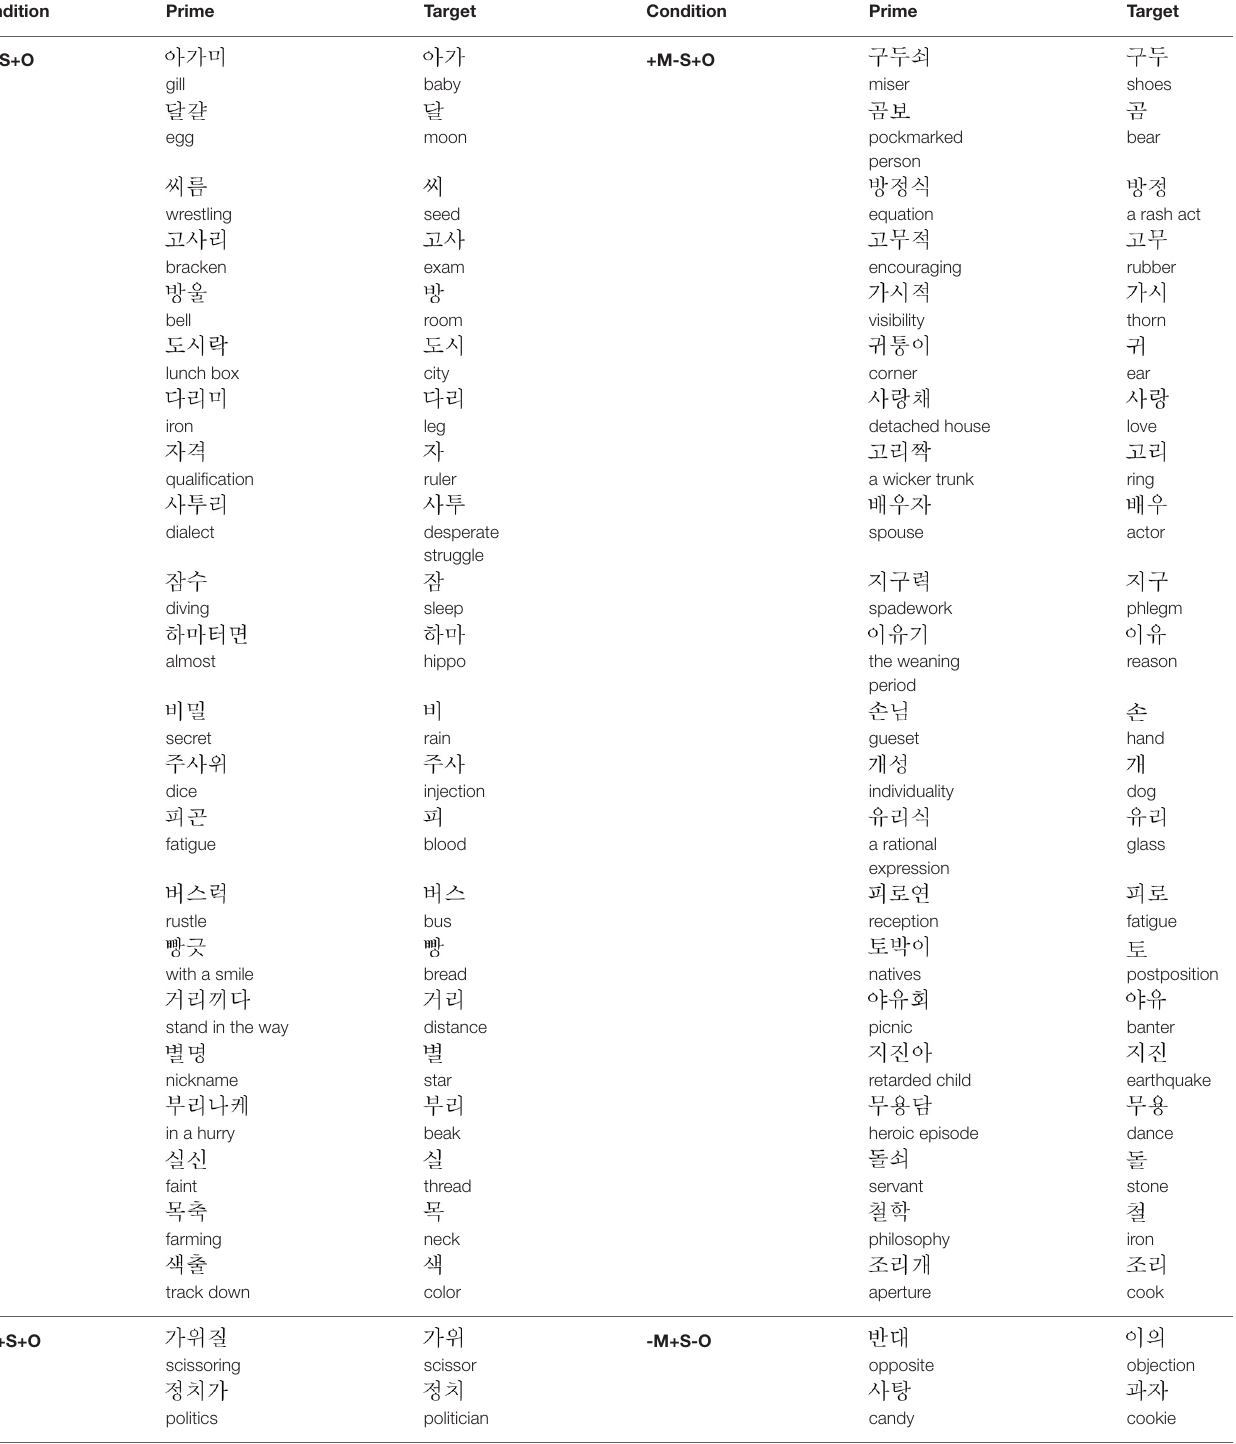
TABLE A1 | Stimuli used in the masked priming lexical decision task. Condition